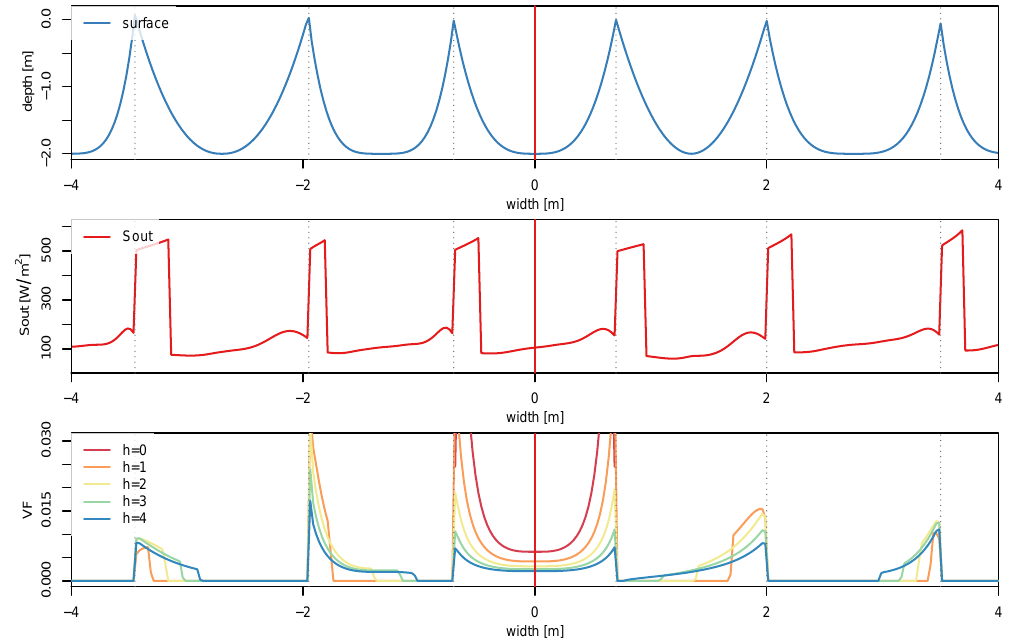
Figure 9. Illustration of the modeled penitente geometry and the effect of height on the radiation received by the sensor: (a) simulated 2-D penitente surface of experiment D with a convex shape; (b) S out along the surface for a uniform material albedo; and (c) view factors (i.e., proportion of radiation measured by the sensor coming from segment s 0 ) of the sensor along the surface for different sensor heights ( h ).